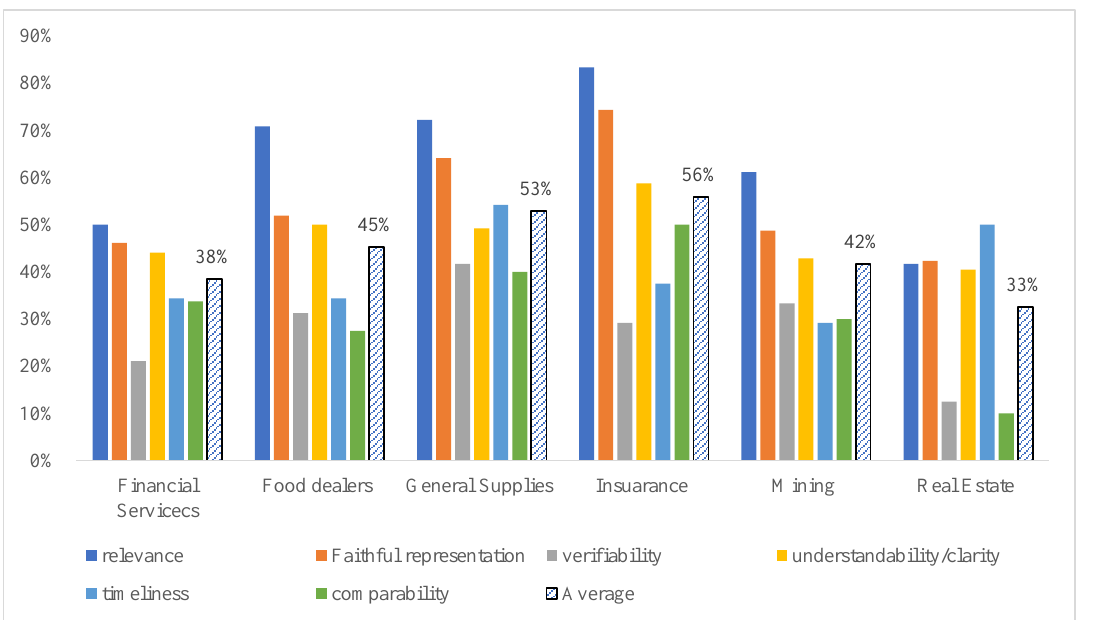
Figure 3. Decision usefulness of integrated reports produced in Namibia by sectors. Source: Authors’ own illustration.